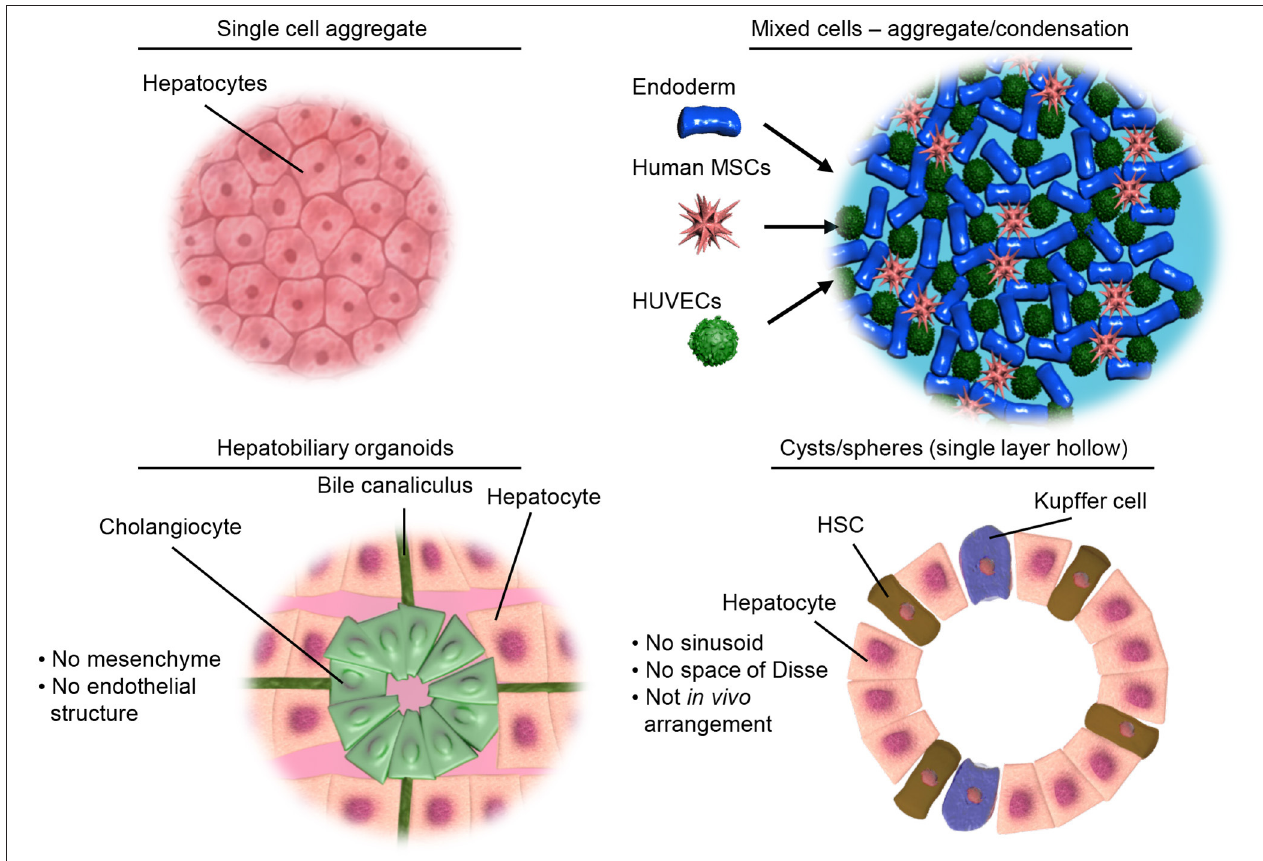
FIGURE 2 | Illustrative examples of different types of 3D culture models. Top left, showing a simple aggregate of a single cell type. Top right, showing aggregates of mixed cell types but limited structural organization as achieved by condensation of pre-differentiated cells. Bottom left, representing the hepatobiliary organoids recapitulating the structure and interactions of the liver parenchymal cells. Bottom right, showing organoids containing both parenchymal and non-parenchymal cells of the liver necessary for modeling inflammation and liver